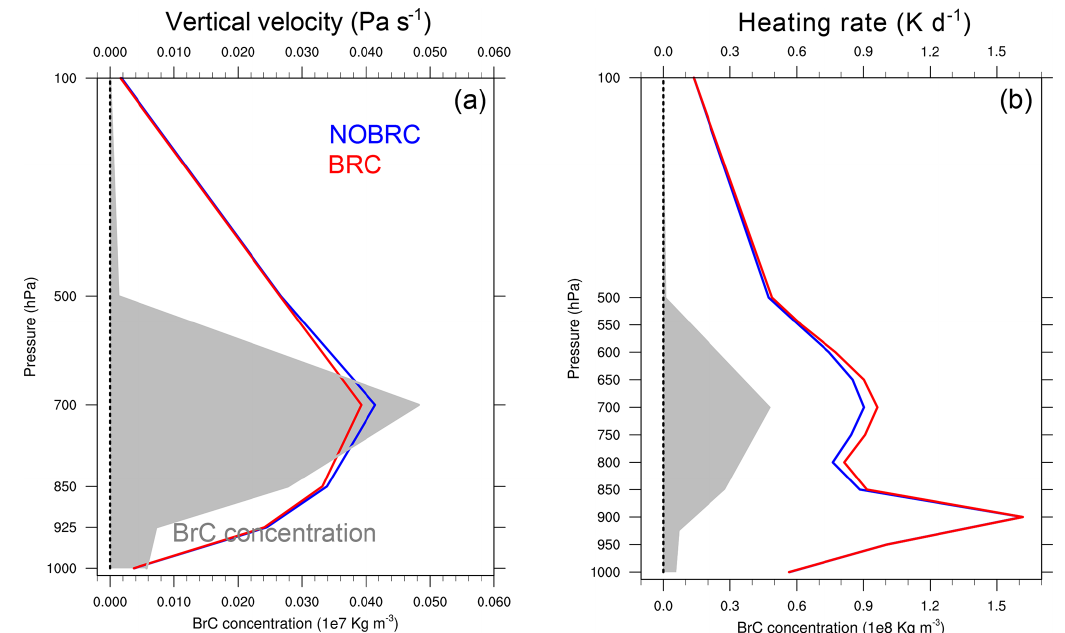
Figure 14. JAS mean over the OCE region of vertical velocity (Pas − 1 , a ) and shortwave heating rate (Kd − 1 , b ). BrC concentrations have been added in both figures (note the different x